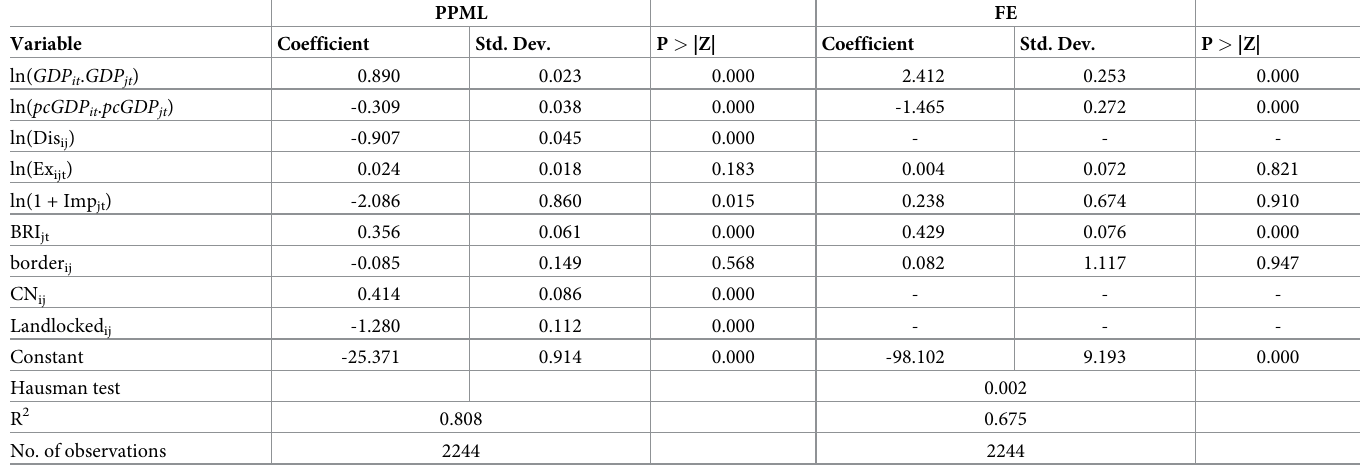
Table 5. Estimates of the gravity